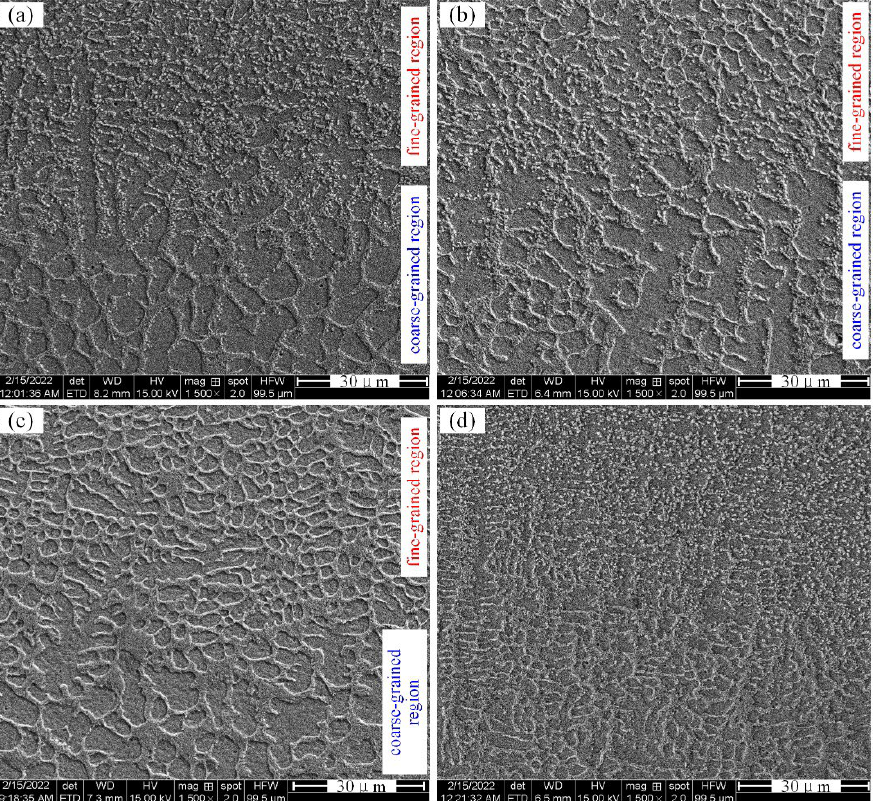
Figure 4. The internal microstructure of AM alloy. ( a ) Specimen-1, ( b ) Specimen-2, ( c ) Specimen-3, ( d ) Specimen-4.